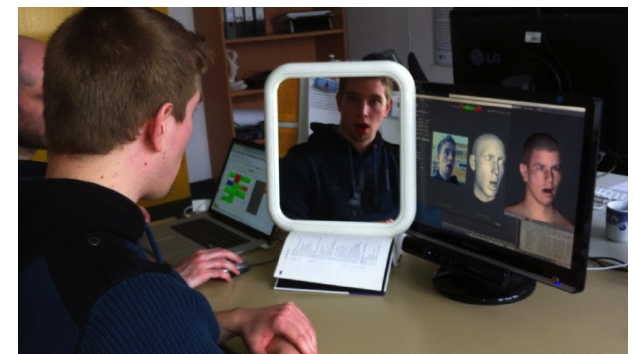
Figure 7. The user study